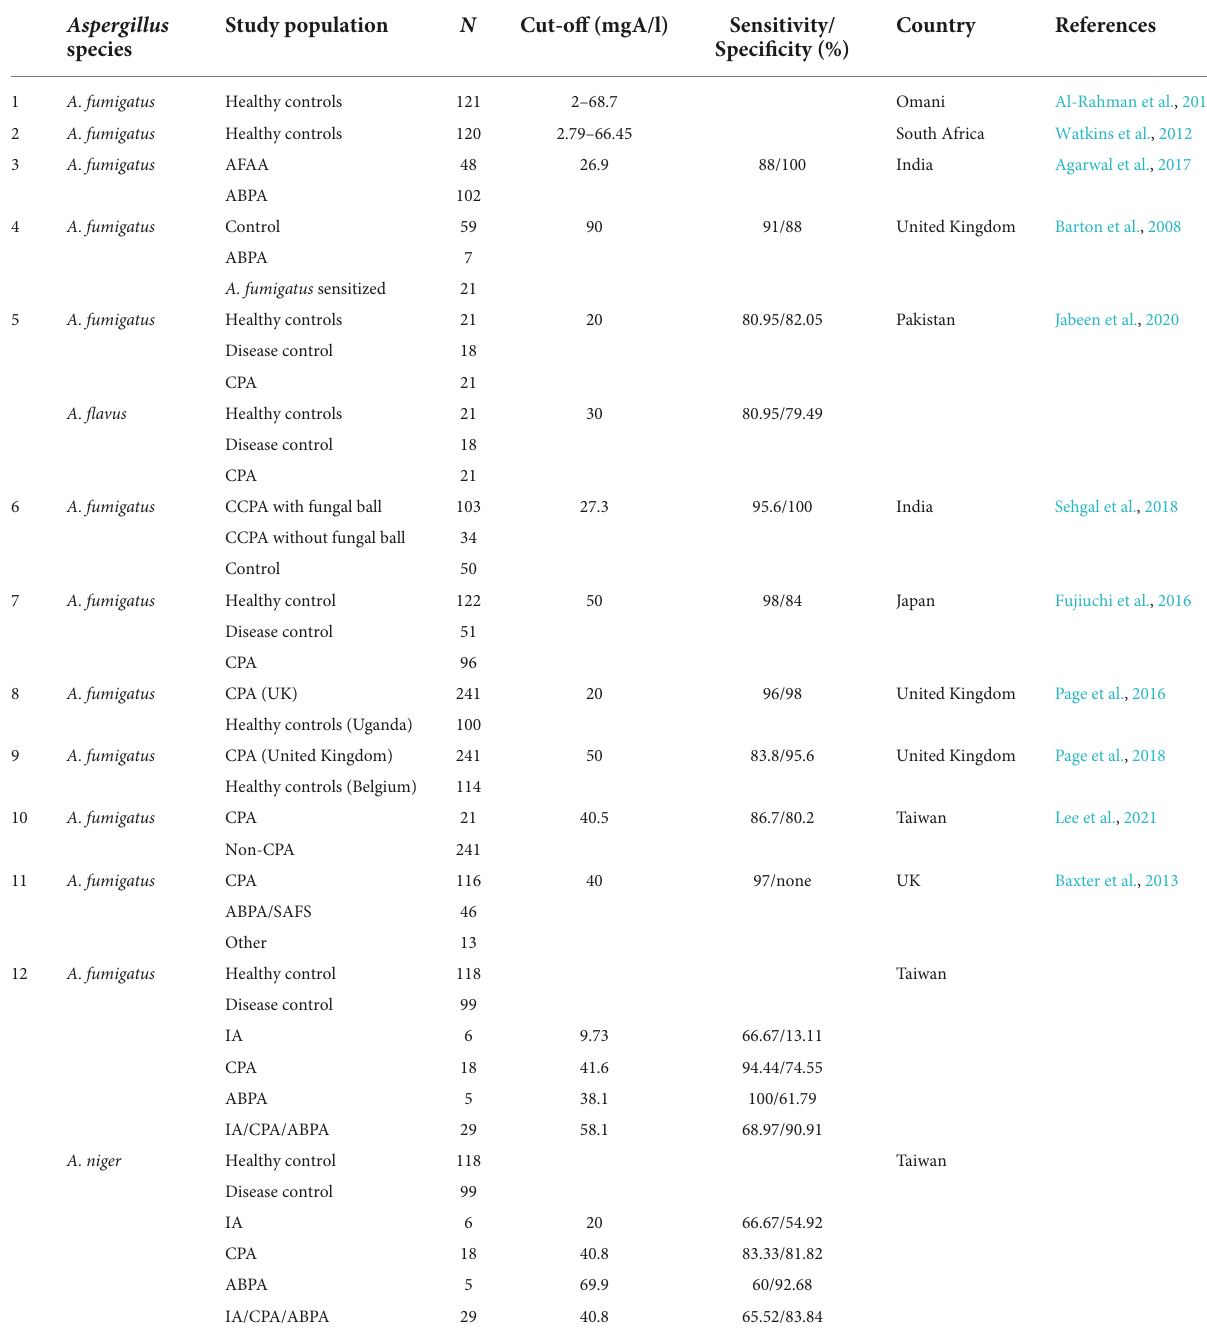
TABLE 3 A narrative review of Aspergillus -specific IgG in previous